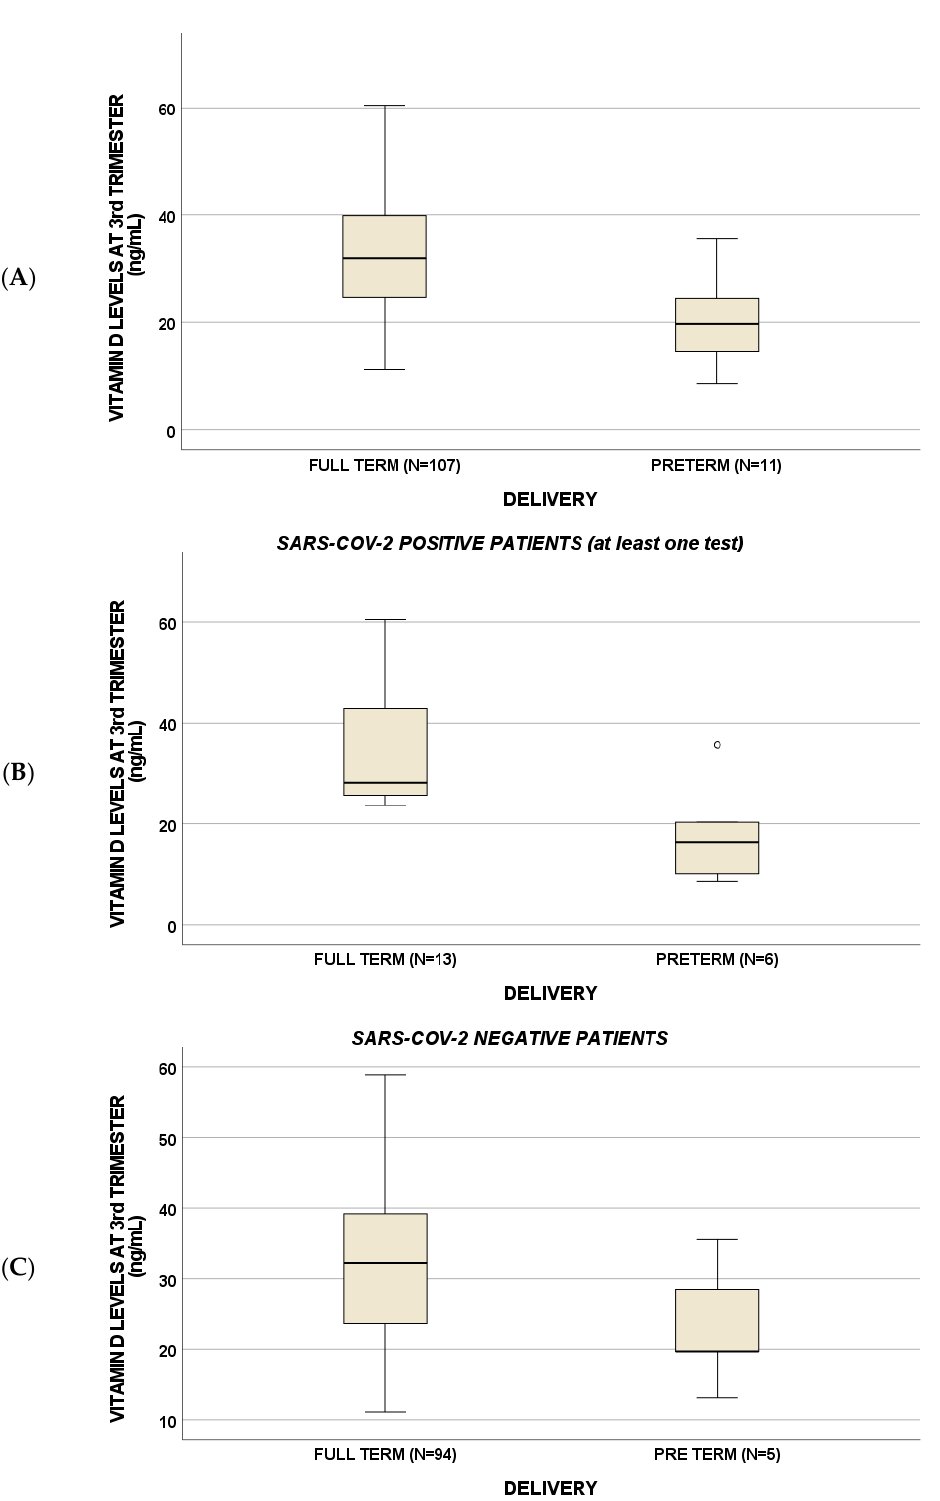
Figure 3. Third-trimester vitamin D levels were lower in preterm births compared to full-term pregnancy ( p < 0.001) ( A ): in particular, a p -value of 0.01 was suggested for positive subjects ( B ), whereas p = 0.07 for negative women ( C ). Circles indicate "out" values. Table 3. Median 25-vitamin D levels (ng/mL) in preterm births (N = 11) compared to full-term pregnancy (N = 107).